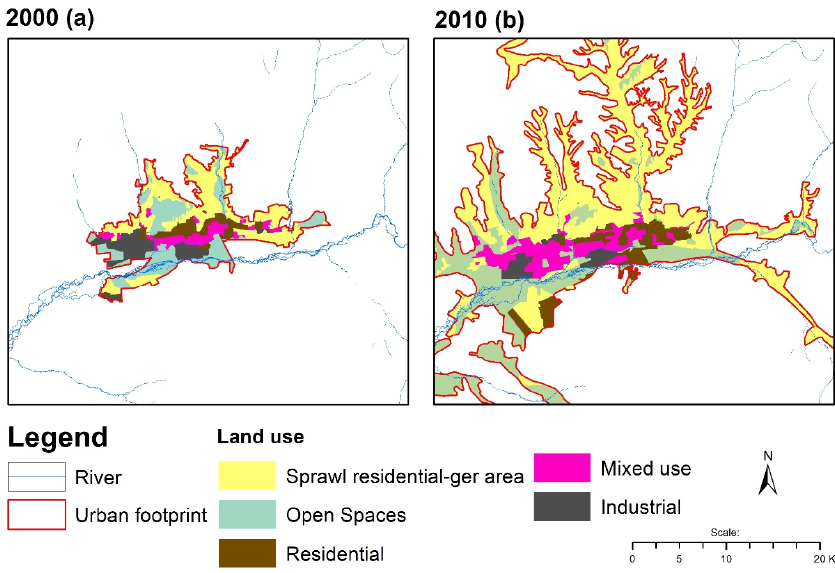
Figure 2. Land-use map of Ulaanbaatar, in ( a ) 2000 and ( b ) 2010.